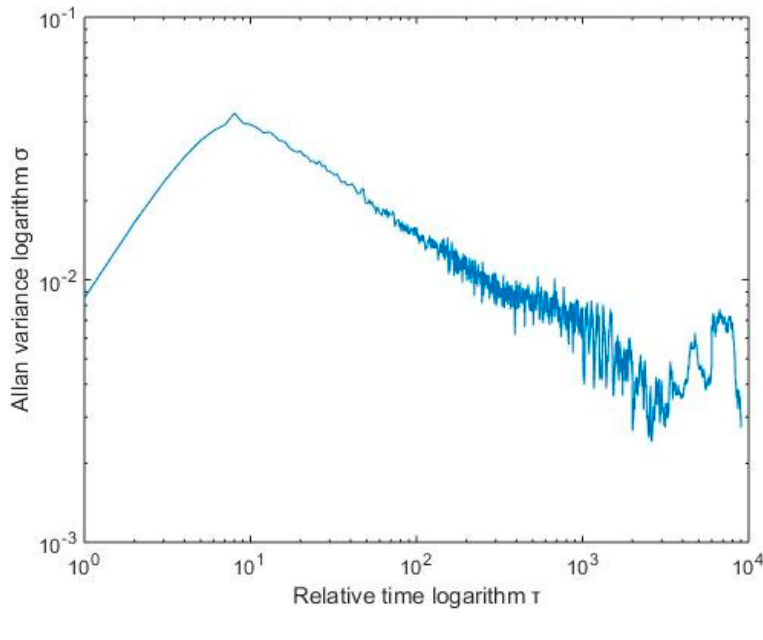
Figure 11. Allan variance curve. Table 3. X-axis values of the parameters Allan variance.